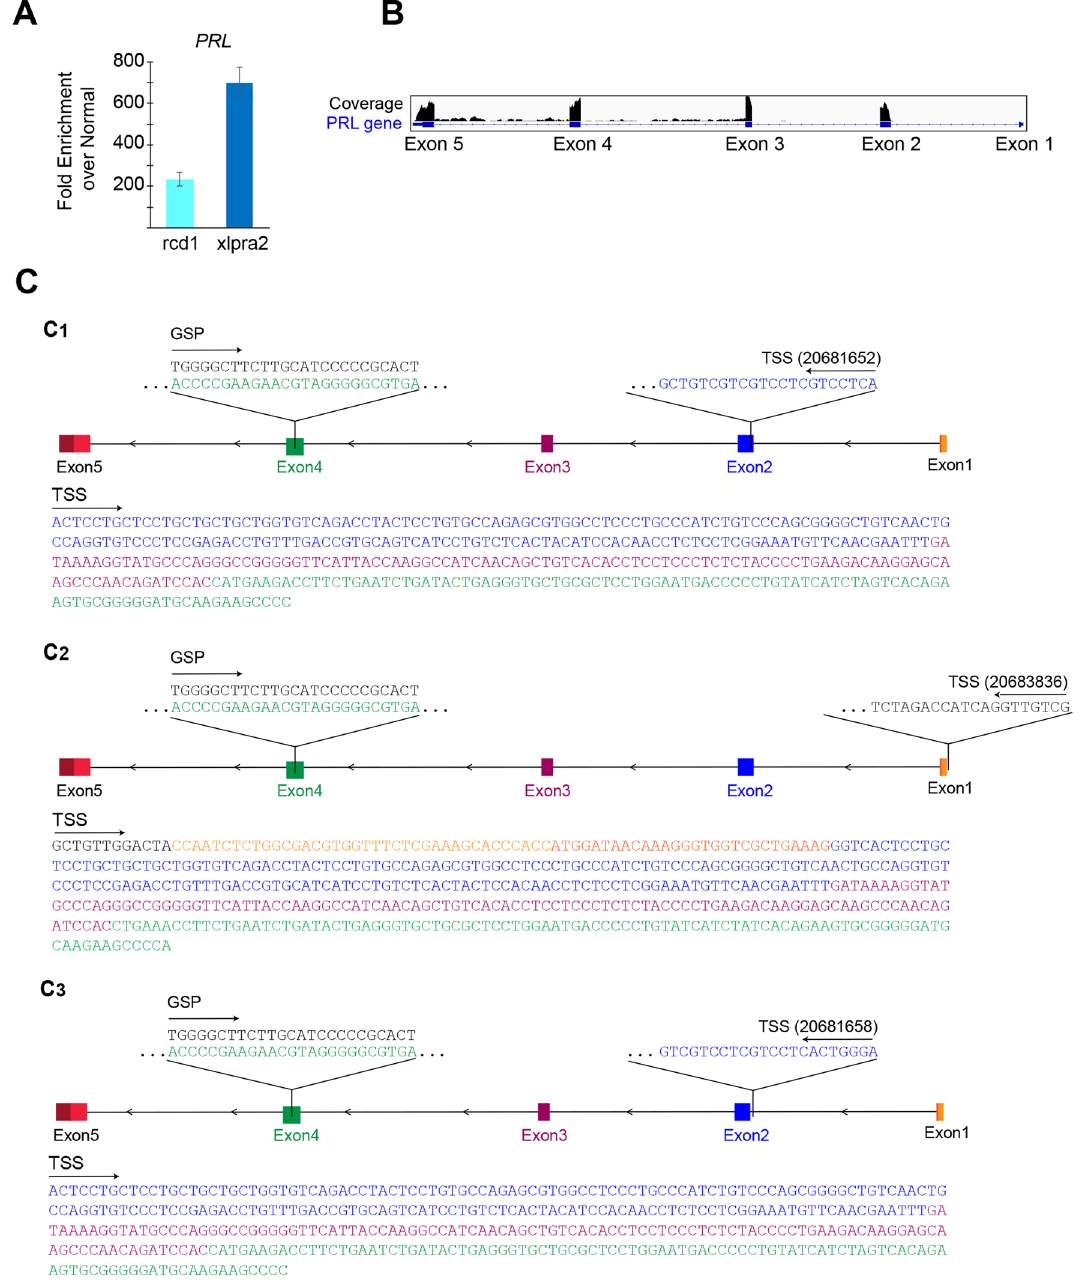
Figure 1. Canine retinal Prolactin isoform lacks exon 1. (A) Fold enrichment of PRL mRNA in rcd1 and xlpra2 retinas over normal (n = 3 animals per group) ( B) Representative graph derived from Integrated Genomic View (IGV) showing RNAseq (GSE97638) 33 reads mapped by STAR for the PRL exons expressed in retinas of rcd1 and xlpra2 dogs. The annotated 5 exons present in the reference (CanFam3.1) are shown, however, only exons 2, 3, 4 and 5 show any coverage. No reads were mapped to exon 1. C) Transcription start site (TSS) for dog retina (n = 4) (C1) and pituitary (n = 2 dogs) (C2,C3) PRL identified by 5 ′ -RACE. GSP = gene specific